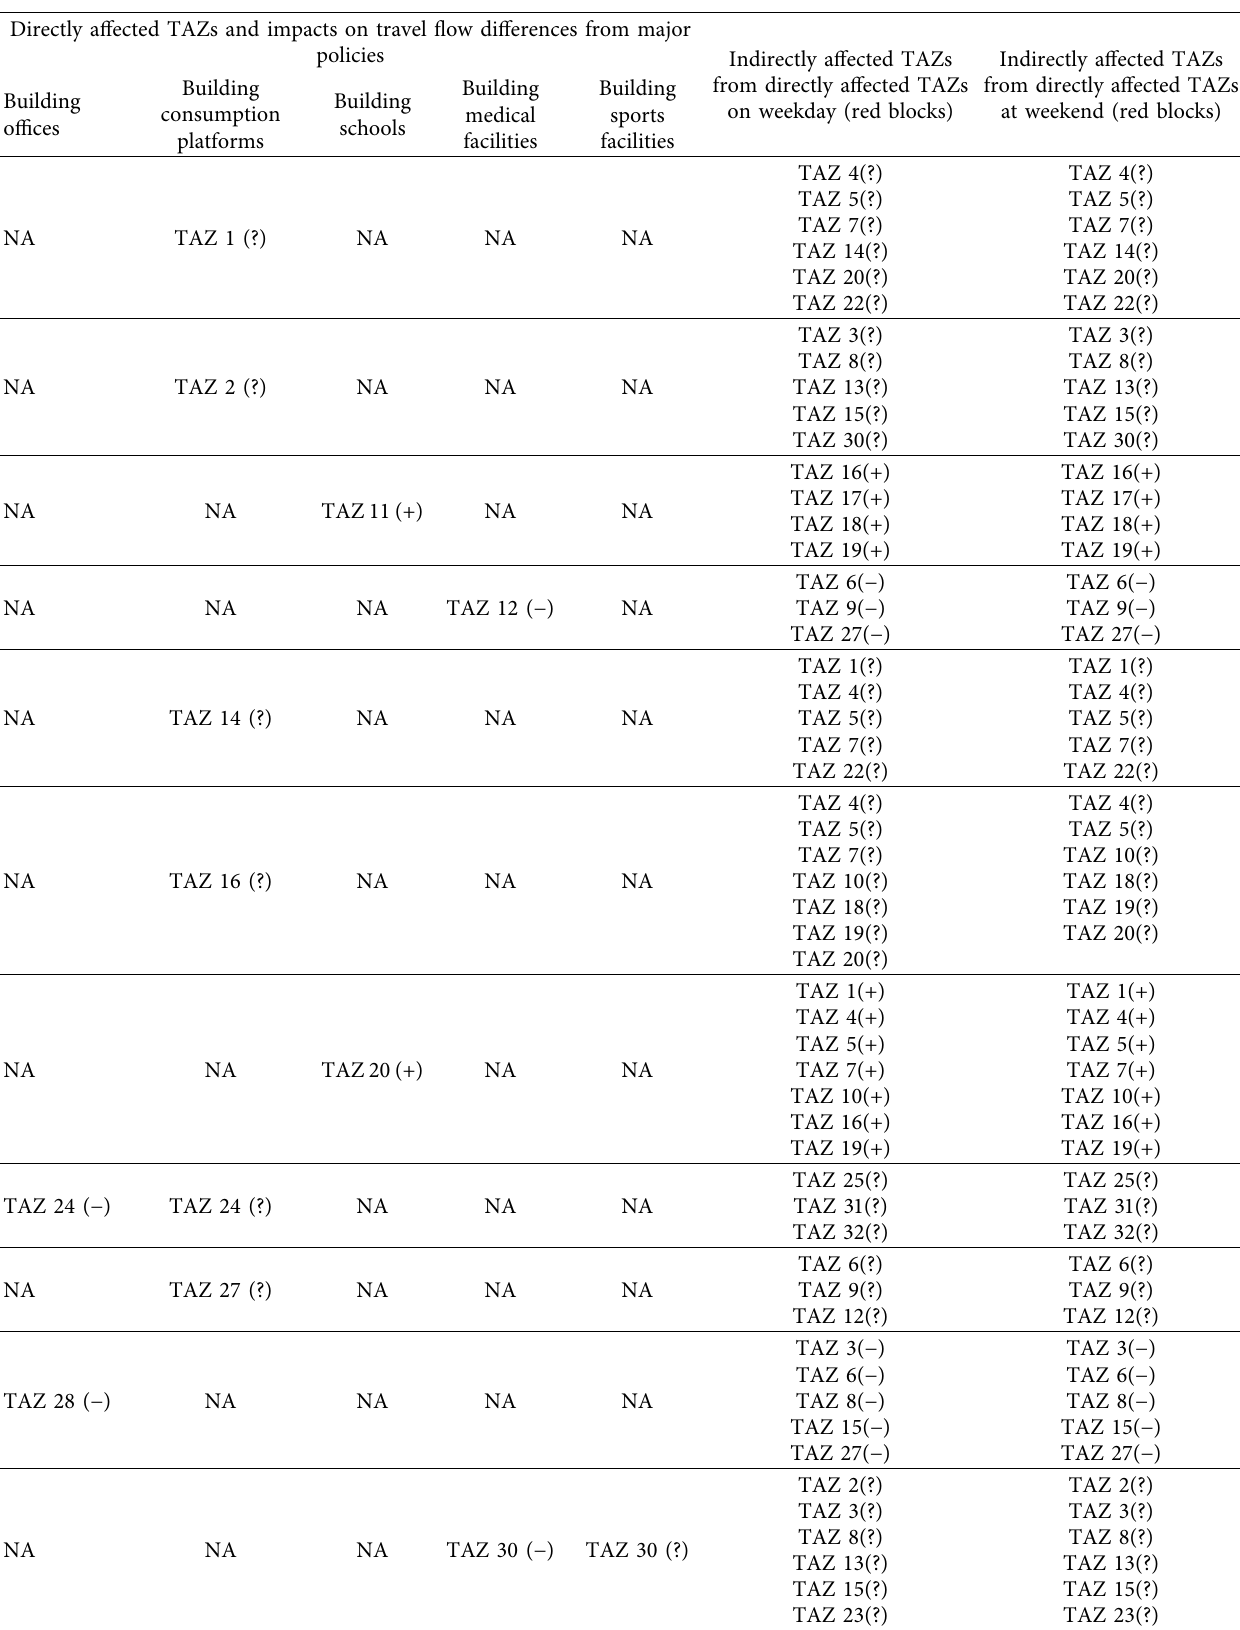
Table 5: Impacts of X145Plan’s major policies on typical